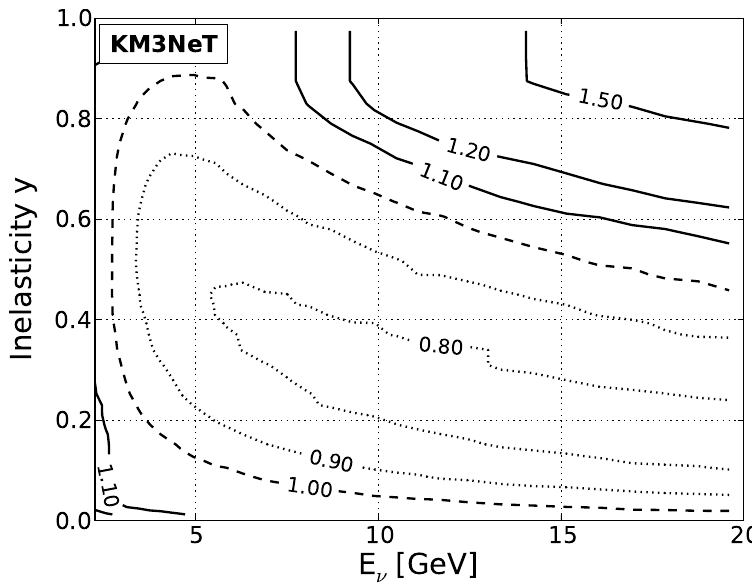
Figure 15 . Ratio of neutrino direction resolution limits for applying the expected neutrino-lepton scattering angle method over the limits for the naive four-momentum conservation method (cf. (cid:12)gure 12) for (cid:23) e CC events in the overall limit as a function of E (cid:23) and inelasticity y . A ratio < 1 indicates the parameter space where the expected scattering angle method is more accurate.